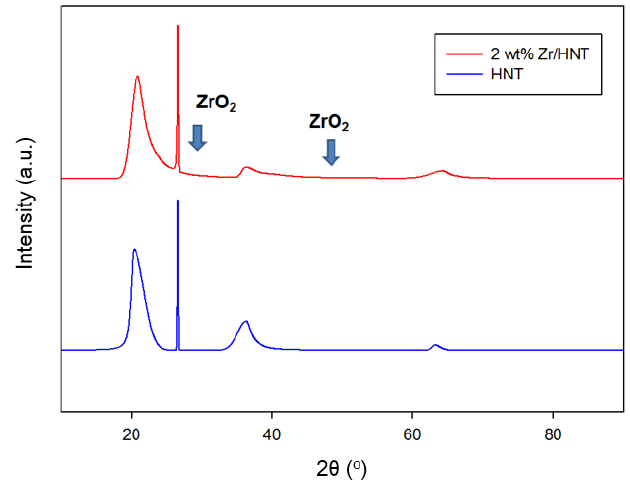
Figure 4. X-ray diffraction patterns of HNT and Zr/HNT.